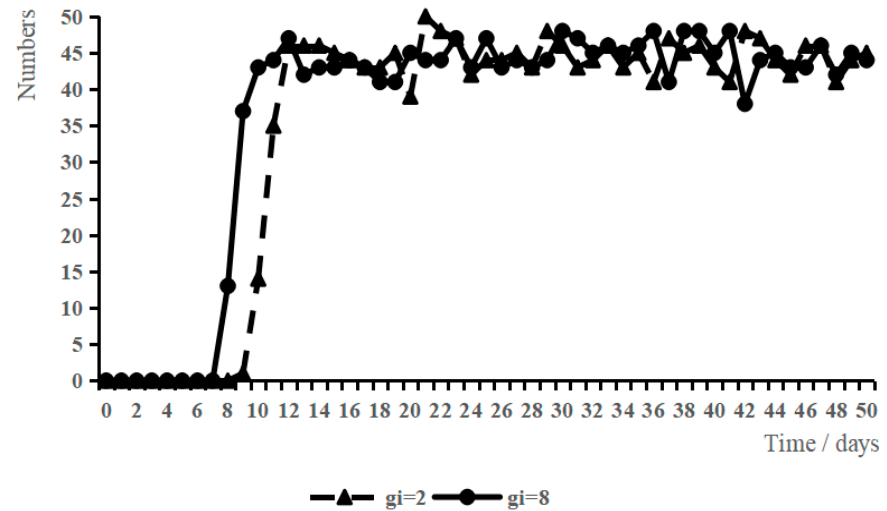
Figure 5. Effect of GI on WSB.4.2. Multi-Variable Experiment. When GI = 8, the other variables were initial values and the workers’ perceived GKS was at a high level. The overall growth with time of the construction workers’ safety behaviors was roughly the same as that when GI = 2. However, when t = 7, workers started to adopt safety behaviors; when t = 11, the number of workers who adopted safety behaviors reached a relatively high point, and subsequently fluctuated around this value. With IGII, GI, and GKS being set as adjustment variables and other variables being set as initial values, four scenarios were set: (IGII, GI, GKS) = (2, 2, 2), (IGII, GI, GKS) = (8, 2, 2), (IGII, GI, GKS) = (8, 8, 2), and (IGII, GI, GKS) = (8, 8, 8). The variation in WSB for all the scenarios was obtained by simulation analysis, as shown in Figure 6.